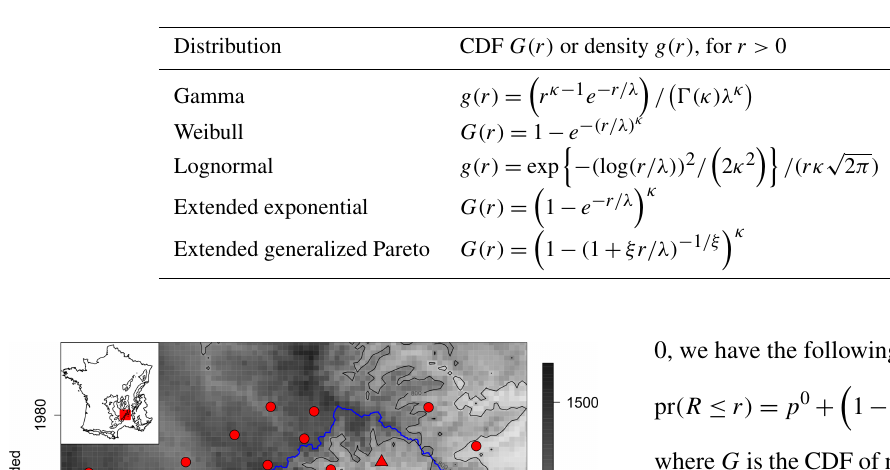
Table 1. Considered models for the marginal distributions of nonzero rainfall. (cid:48) in the Gamma density is the complete Gamma function ∞ R (cid:48)(κ) = r κ − 1 e − r d r . 0